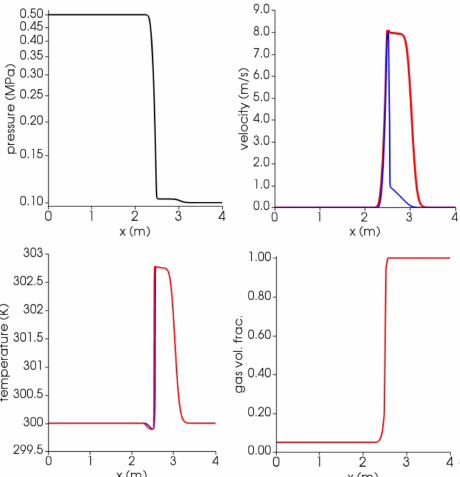
Figure C4. Results at time t = 0 . 0015s for the air–water shock tube with liquid phase switching from continuous to dispersed. Blue lines: liquid (water); red lines: gas (air). At time 0, the interface di- viding the high-pressure (left, l) from low-pressure (right, r) zone is placed at 2.5m. Initial conditions: P l = 0 . 5MPa, P r = 0 . 1MPa; T l = T r = 300K for both phases; gas volume fraction α l = 0 . 05, α r = 1; U l = U r = 0 for both phases. Isobaric heat capacities of = 1004 . 5Jkg − 1 K − 1 and C P = gas air and liquid water are C P g l 4195Jkg − 1 K − 1 , respectively (https://webbook.nist.gov/, last ac- cess: 27 April 2022). Prandtl numbers of air and water are 0.7 and 2.289, respectively, corresponding to thermal conductivities of 0.02 and 0.67WK − 1 m − 1 (https://webbook.nist.gov/, last access: 27 April